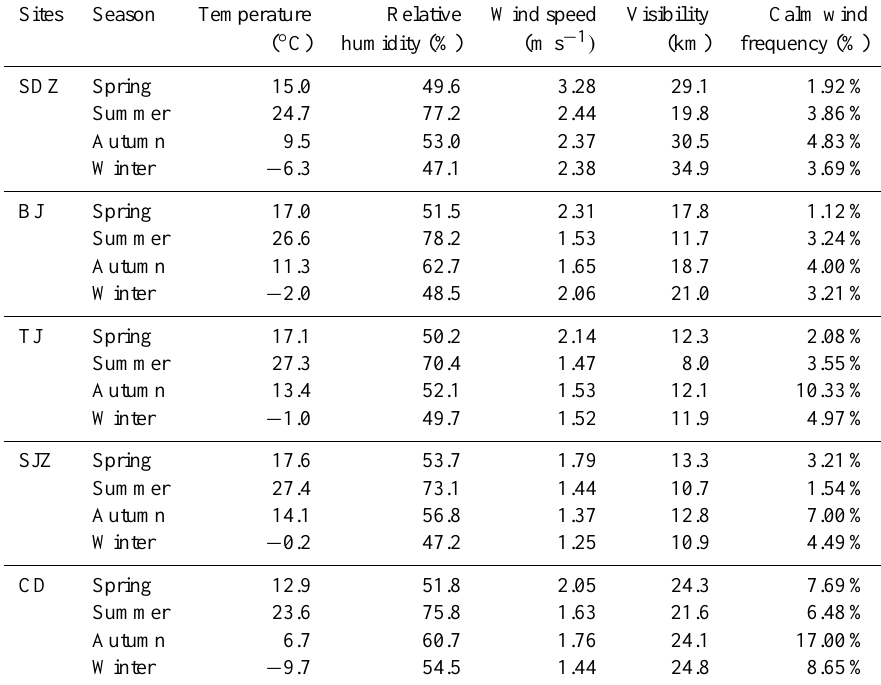
Table 1. Seasonal meteorological conditions at five sampling sites.